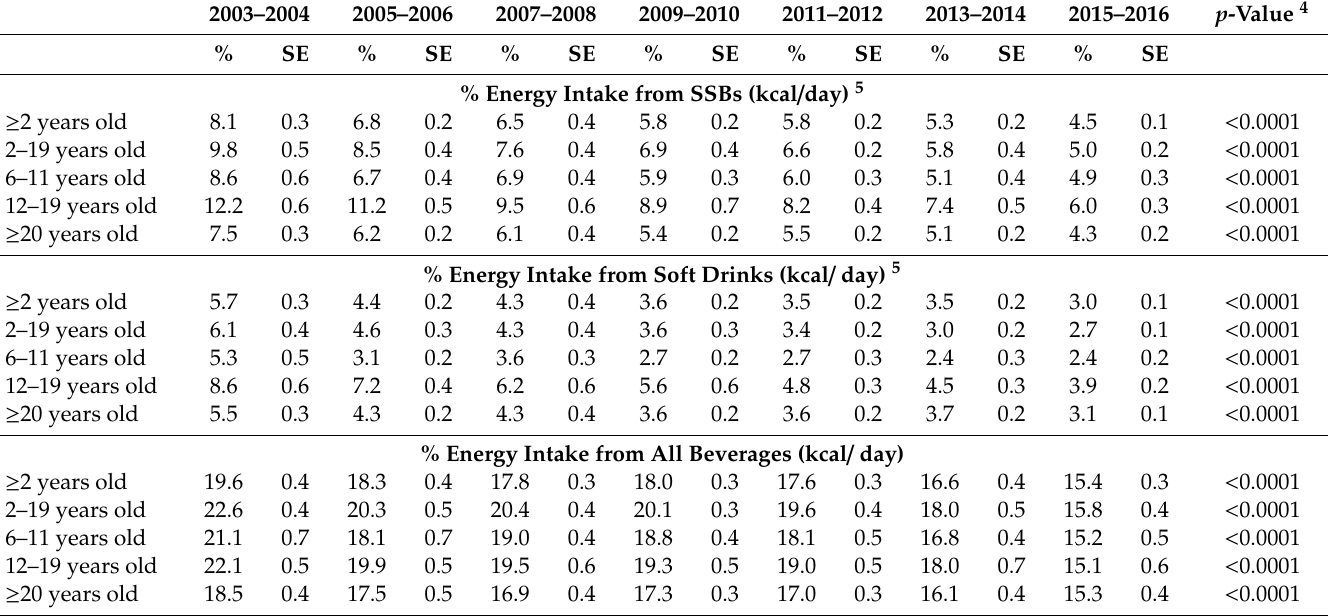
Table 1. Average percentage of energy intake over time in the US by age groups 1–3